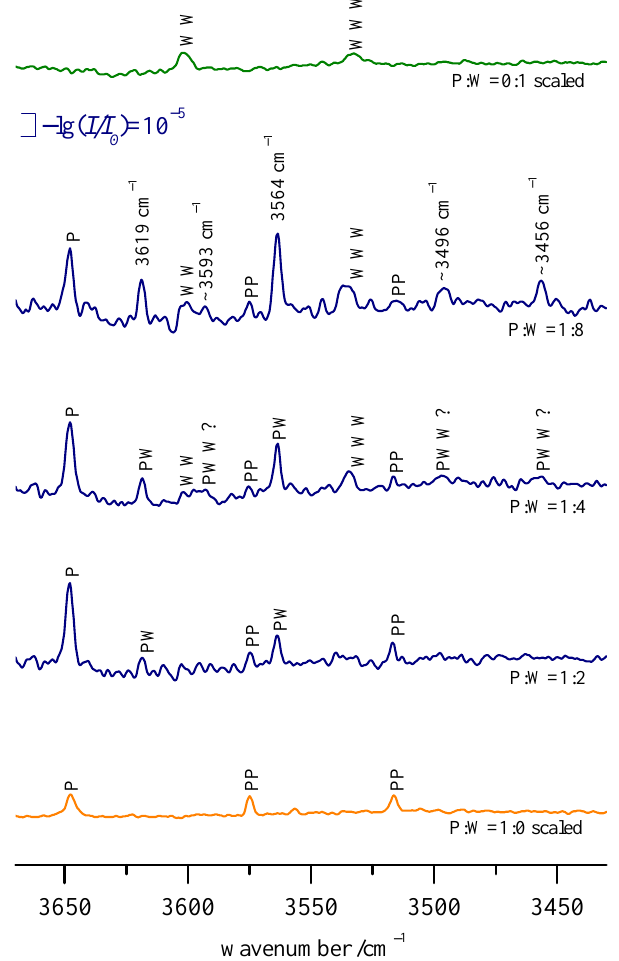
Figure 13. Confirmation of two hydrogen-bonded UV/IR fluorescence depletion OH stretching band centers [63] for the 1:1 hydrate PW of (enantiopure) 1-phenylethanol (P, 0.007% in 750hPa helium), by increasing the water excess from twofold to eightfold (blue traces, 1000–2200 pulses each) with larger cluster signals showing up at higher concentration. Water dimers (WW) and trimers (WWW) as well as alcohol monomers and dimers (PP [56]) also contribute in this range, as shown by two qualitatively scaled spectral traces at the top and the bottom. PWW trimer labels are adopted from the fluorescence study [63] without further FTIR concentration scaling